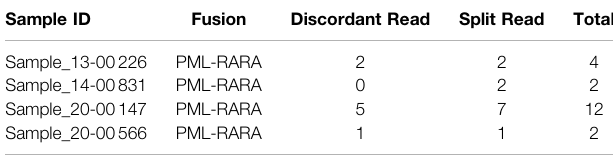
TABLE 2 | The number of samples harboring fusion genes detected from RNA- seq data; number of matched samples with exome sequencing data